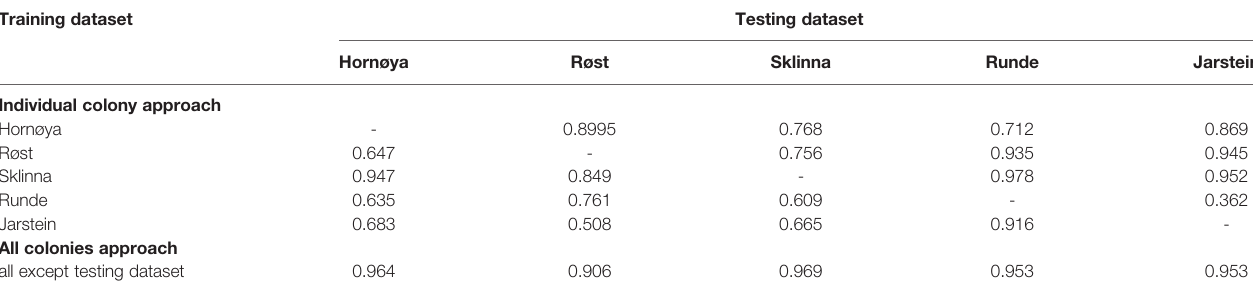
TABLE 3 | AUC results of models based on the individual colonies approach (top) and the all colonies approach (below). Training